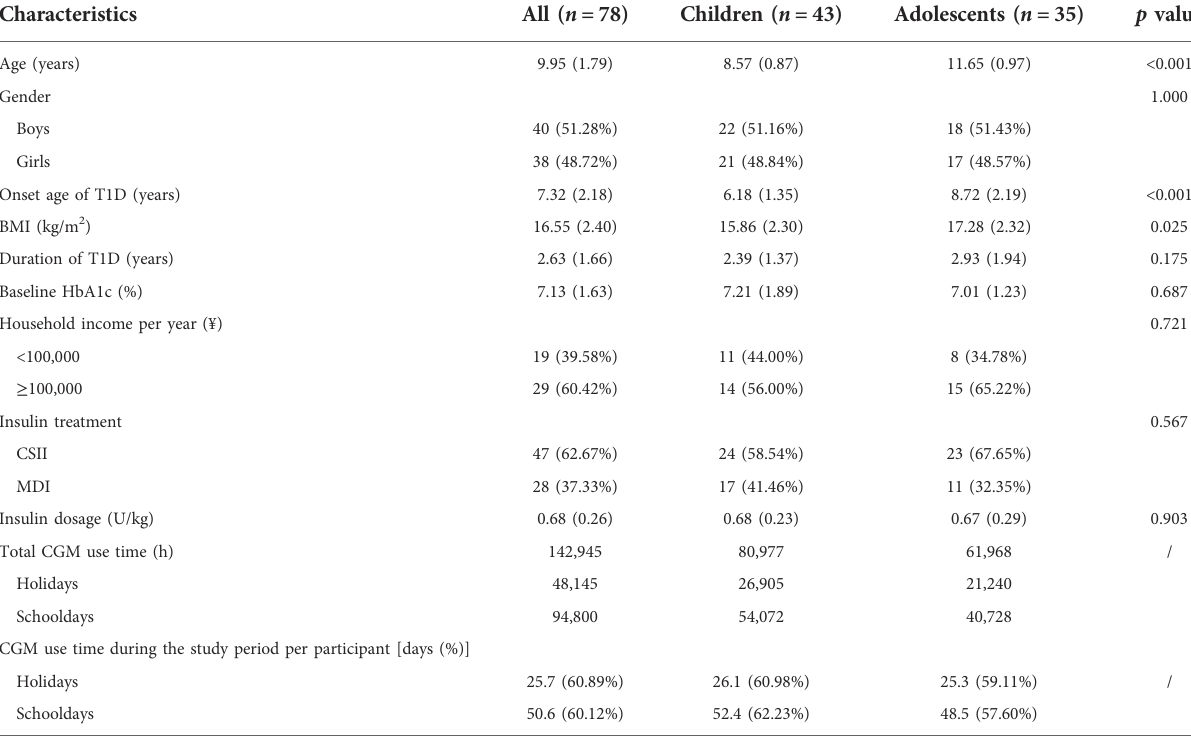
TABLE 1 Baseline characteristics of participants with